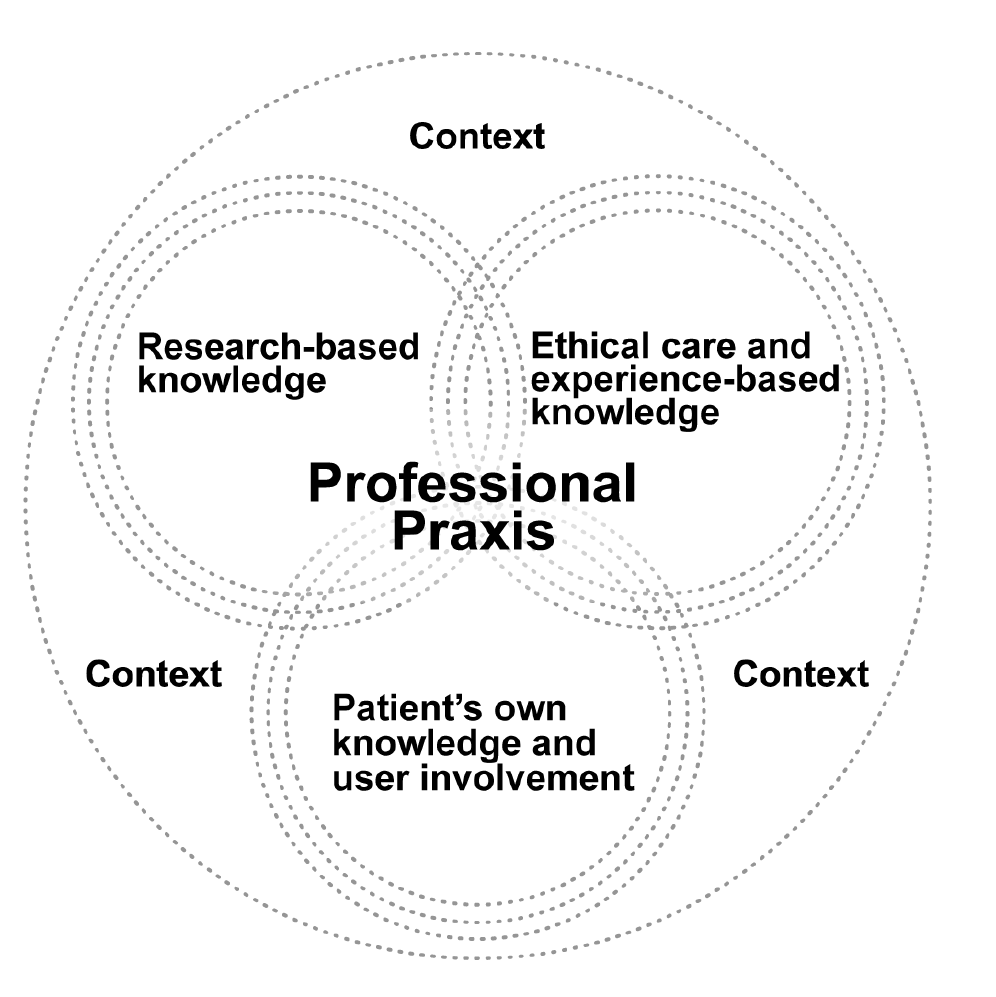
Figure 3 : The Inclusive Evidence Based Practice Model The circles in the Inclusive EBPM include: a) Research-based knowledge b) Ethical care and experience-based knowledge and c) Patient’s own knowledge and user involvement. Further, the different knowledge circles are stippled to illustrate that they are dynamic and that their size will vary from encounter to encounter – intersecting with each other and with the larger circle of context. Professional praxis emerges from this process of intersection between the pluralistic forms of